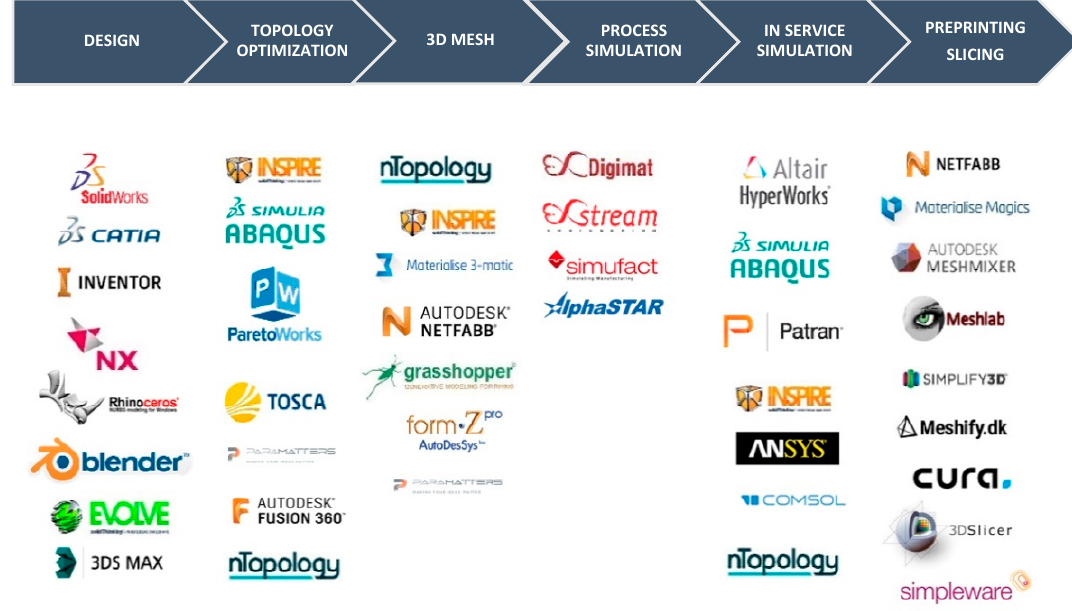
Figure 2. Tools that can be used in the AM process.